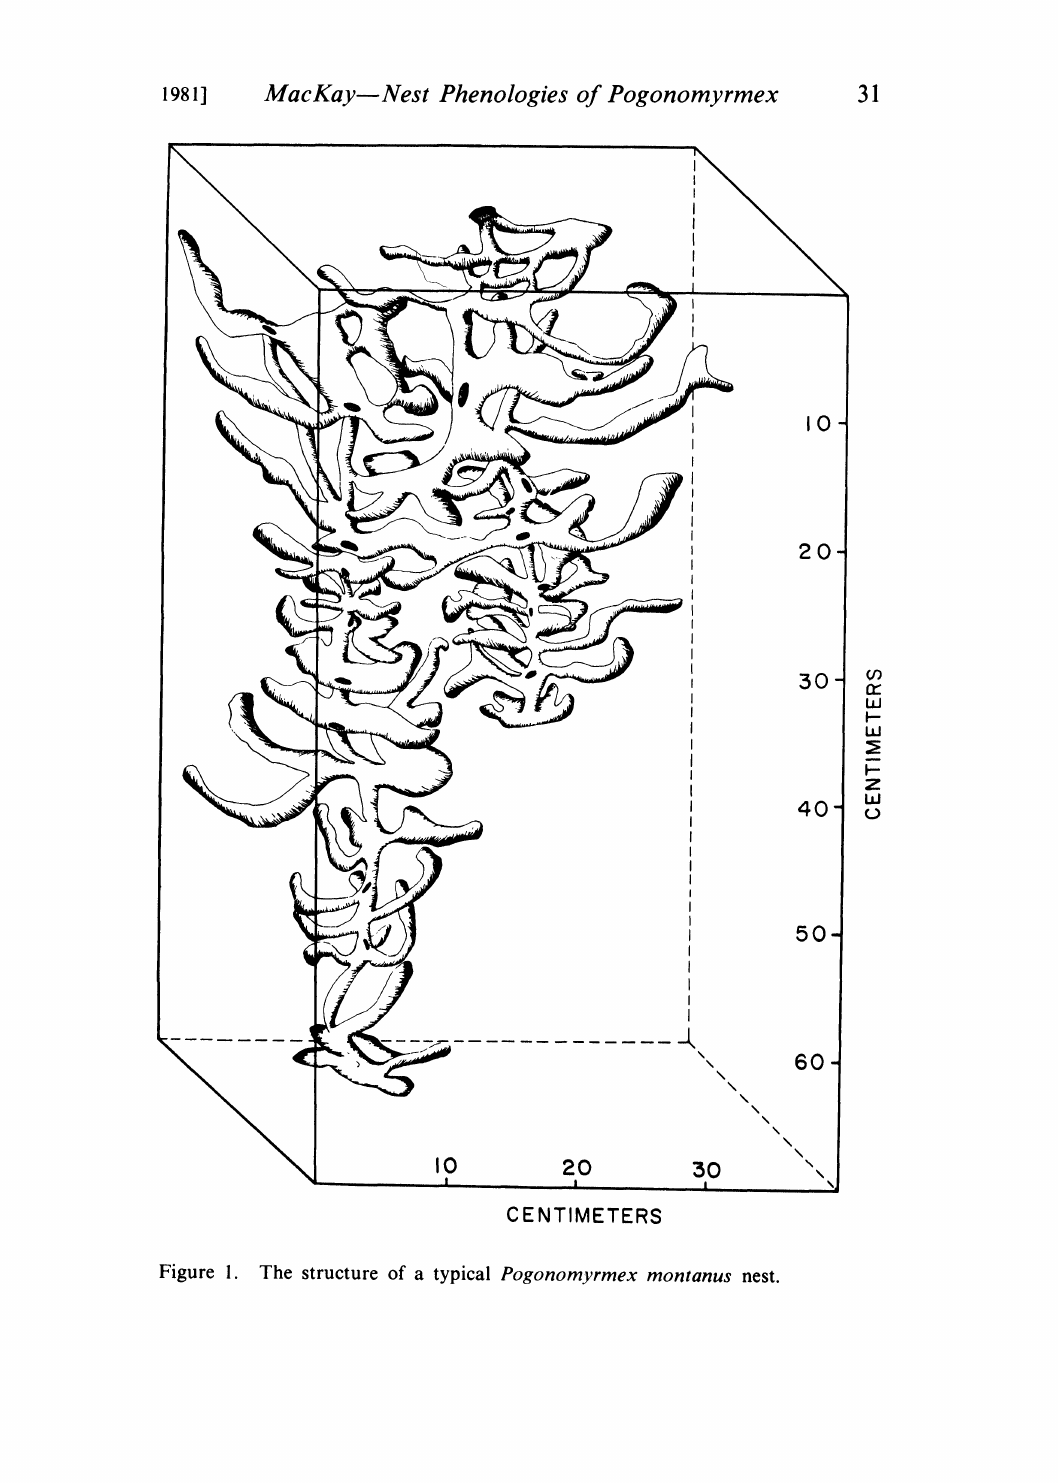
Figure 1. The structure of a typical Pogonomyrmex montanus